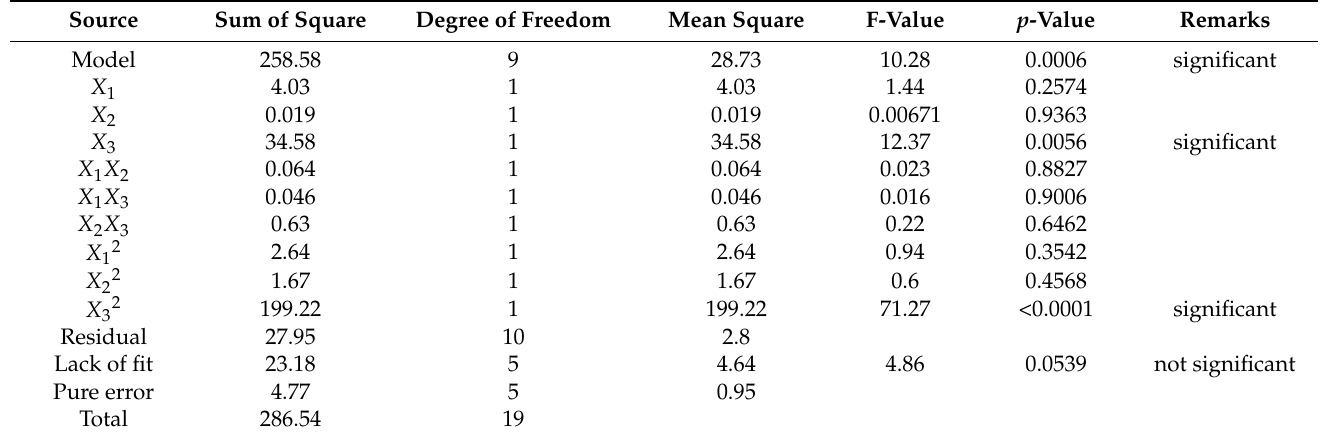
Table A1. Analysis of variance for the predicted total anthocyanin content